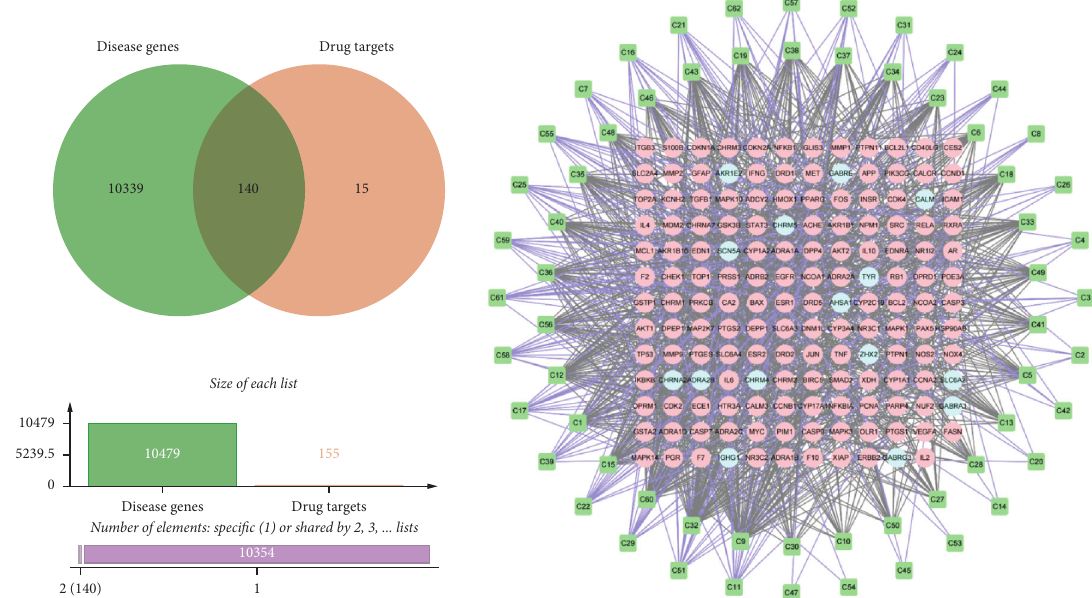
Figure 1: Screening of therapeutic targets and construction of its component